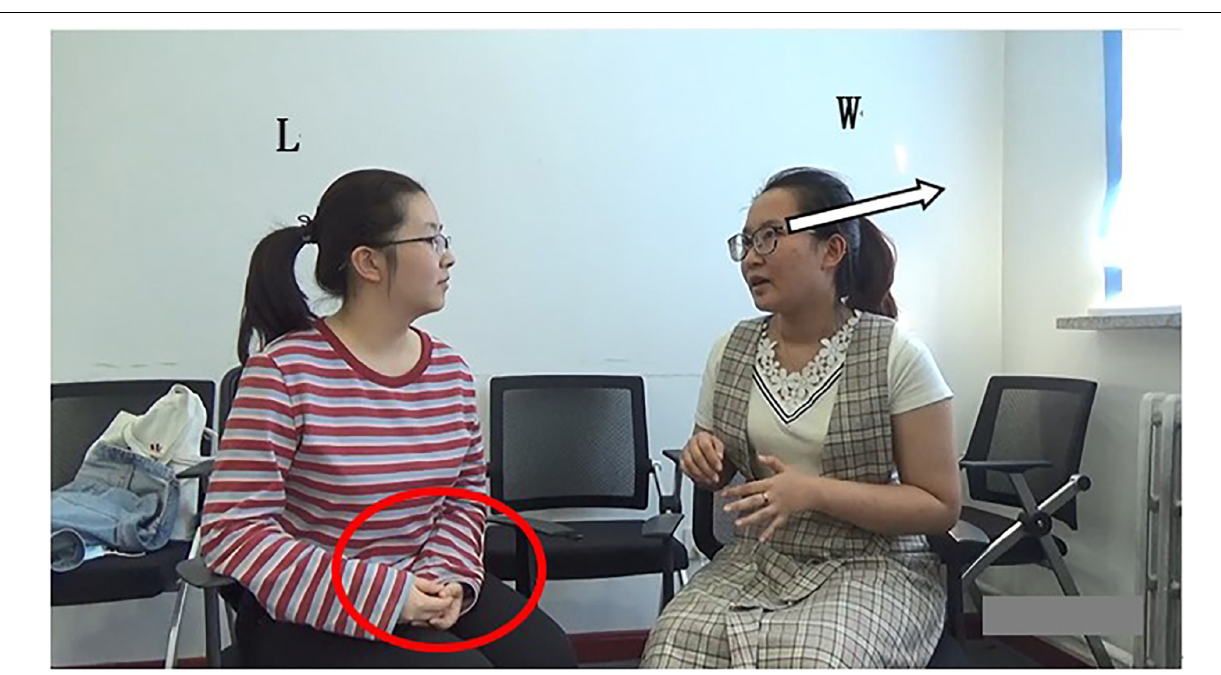
FIGURE 1 | Spectrogram, waveform, pitch trace (dotted line), and intensity trace (solid line) of lines 02–08 in excerpt 1.